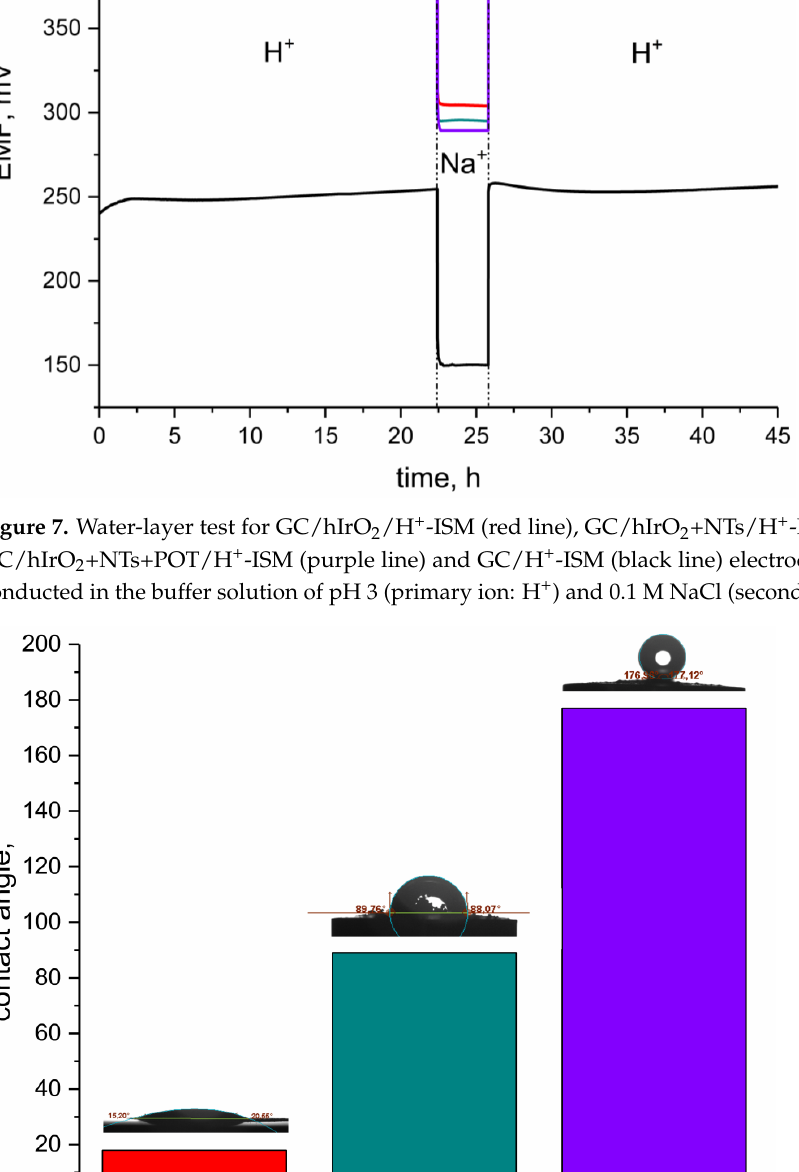
Figure 8. Contact angle values of materials for solid-contact layers for pH-selective electrodes (from left: standalone IrO 2 , double composite IrO 2 -NT and triple composite IrO 2 -NT-POT). 335